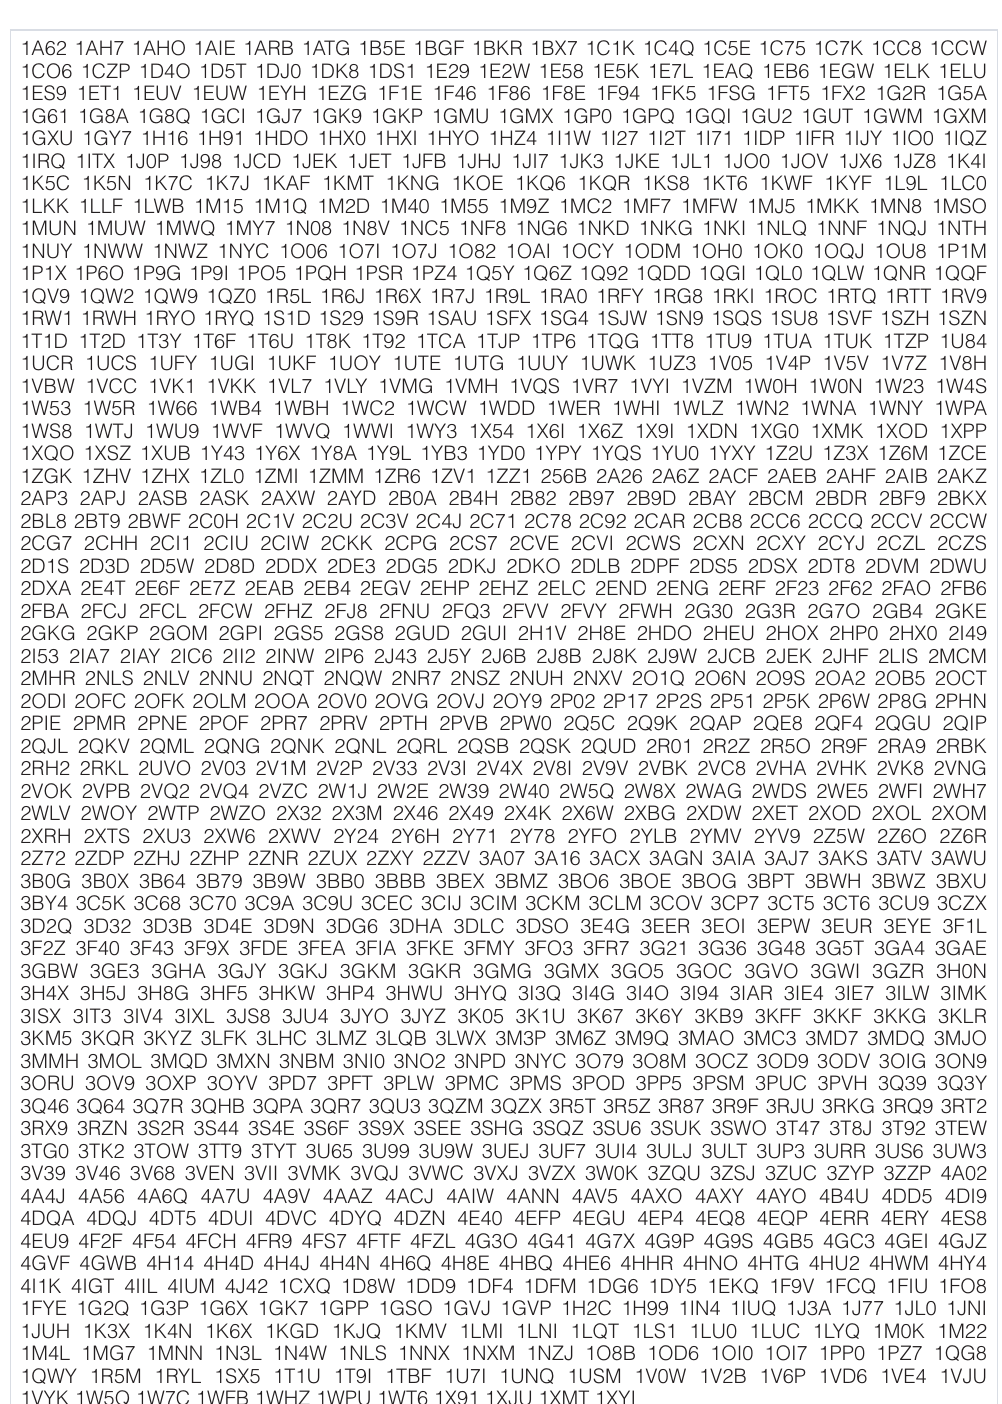
Table S1. Proteins from the PISCES database used for learning values. Set of 1000 proteins from the PISCES database with percentage identity cutoff of 20%, resolution cutoff of 1.6 Å, R-factor cutoff of 0.25, and a RDCC cutoff of 0.012 Å used to learn feature